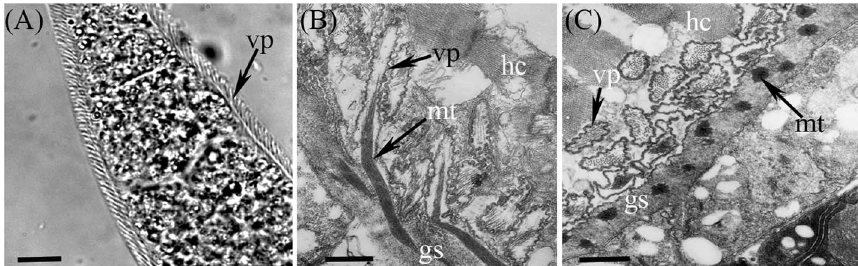
Figure 1. Morphological characteristics of Sarcocystis bertrami sarcocysts isolated from the skeletal muscle of a horse. (A) Sarcocyst (unstained, light microscopy) bound by villar protrusions (vps). Scale bar = 10 l m. (B) Longitudinal section of a sarcocyst (under transmission electron microscopy, TEM). The sarcocyst is surrounded by the host cell (hc), and the sarcocyst wall exhibits numerous vps, which are often bent along the cyst surface. The vps contain bundled microtubules (mt) in the core, which penetrate diagonally into the ground substance (gs). Scale bar = 1 l m. (C) Cross-section of a sarcocyst under TEM. Note the bundle of mt in the gs. Scale bar = 1 l m.